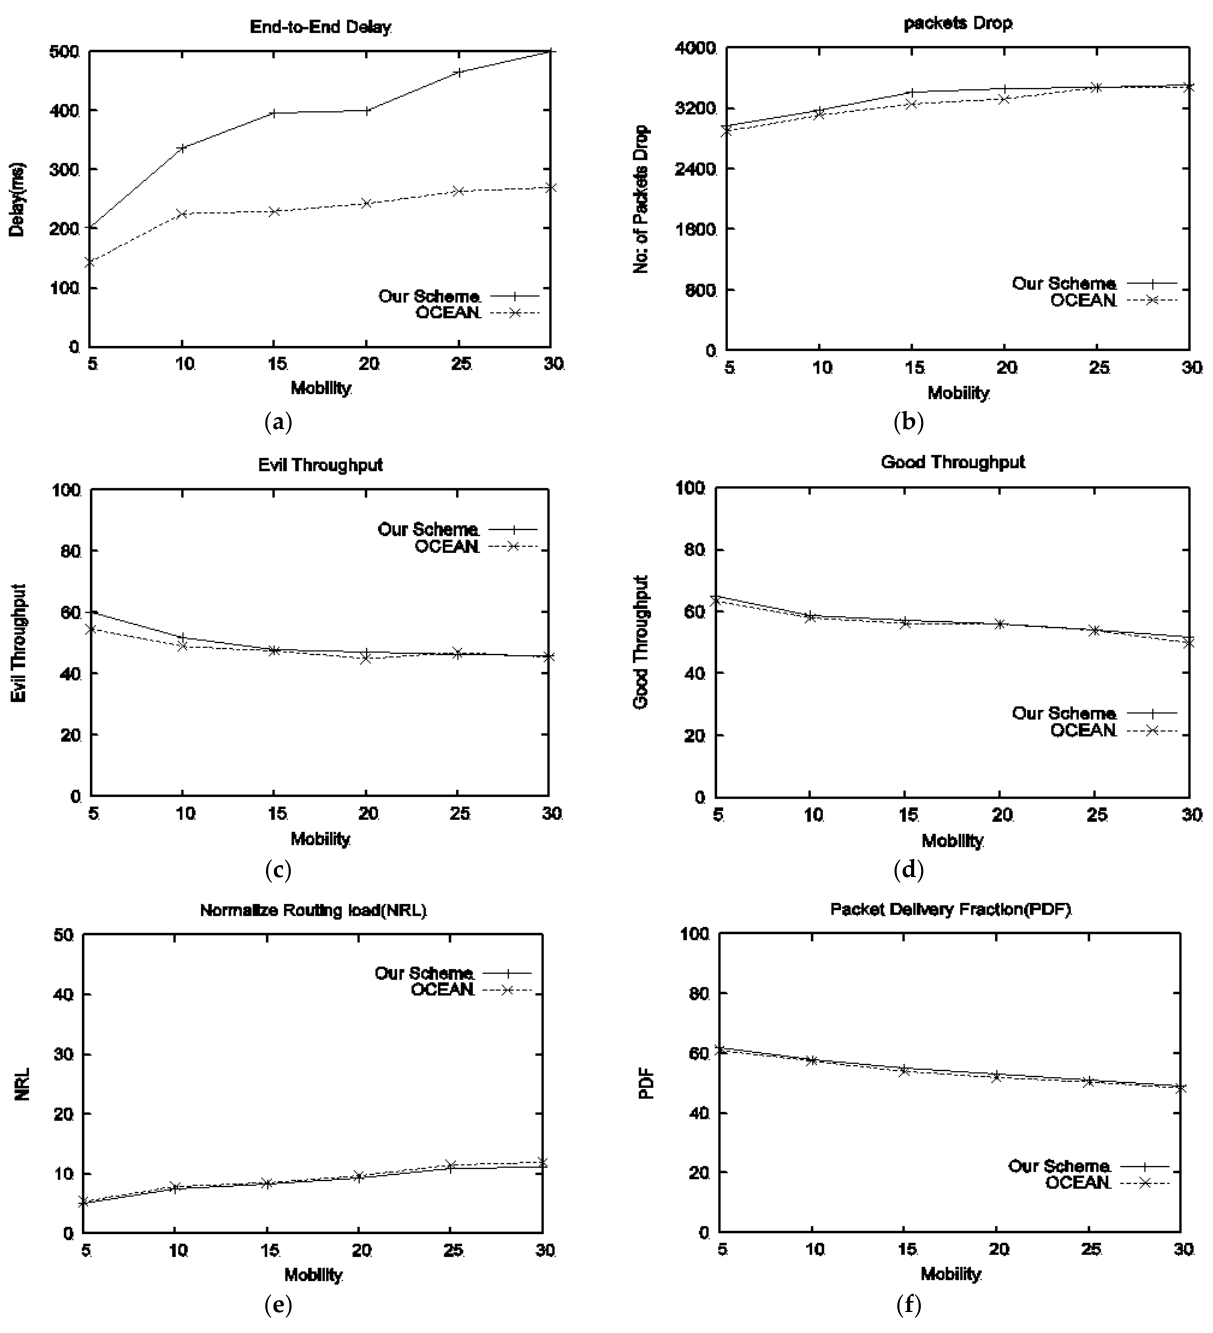
Figure 4. Performance comparison in the presence of type-1 attackers with respect to different speeds of the nodes: ( a ) delay vs. mobility, ( b ) average drop packets vs. mobility, ( c ) evil throughput vs. mobility, ( d ) good throughput vs. mobil- ity, ( e ) NRL vs. mobility, ( f ) PDF vs.